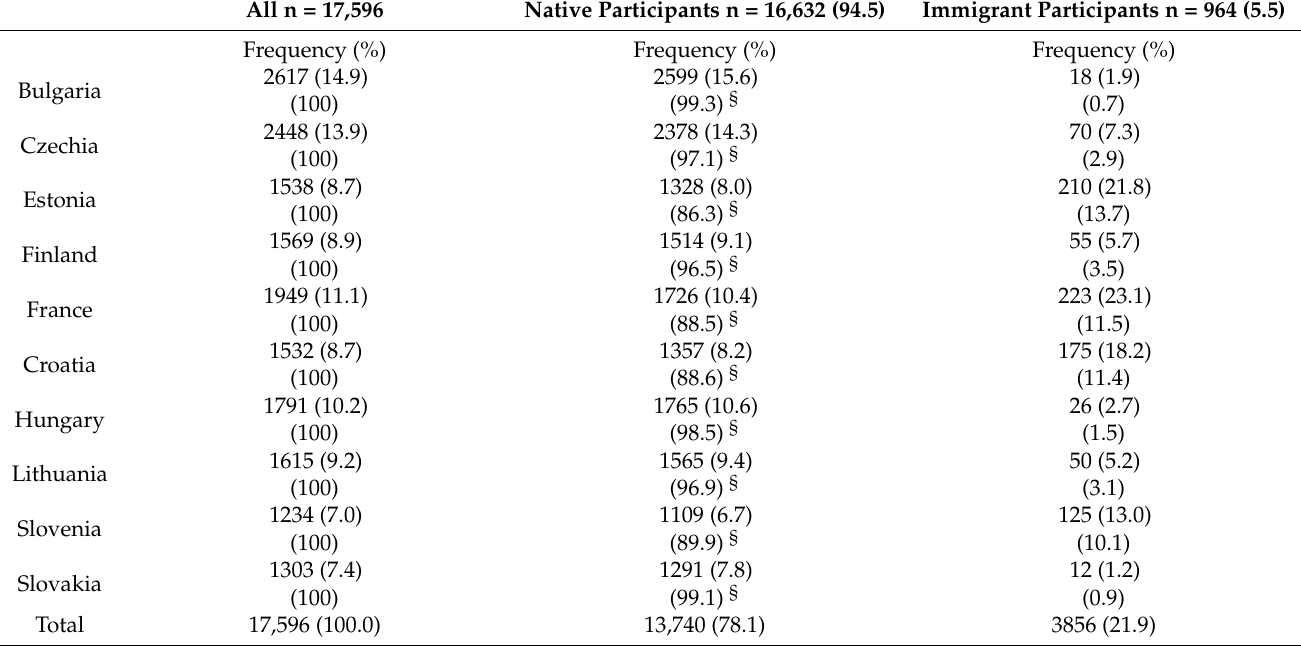
Table A1. Distribution of countries overall and by immigration